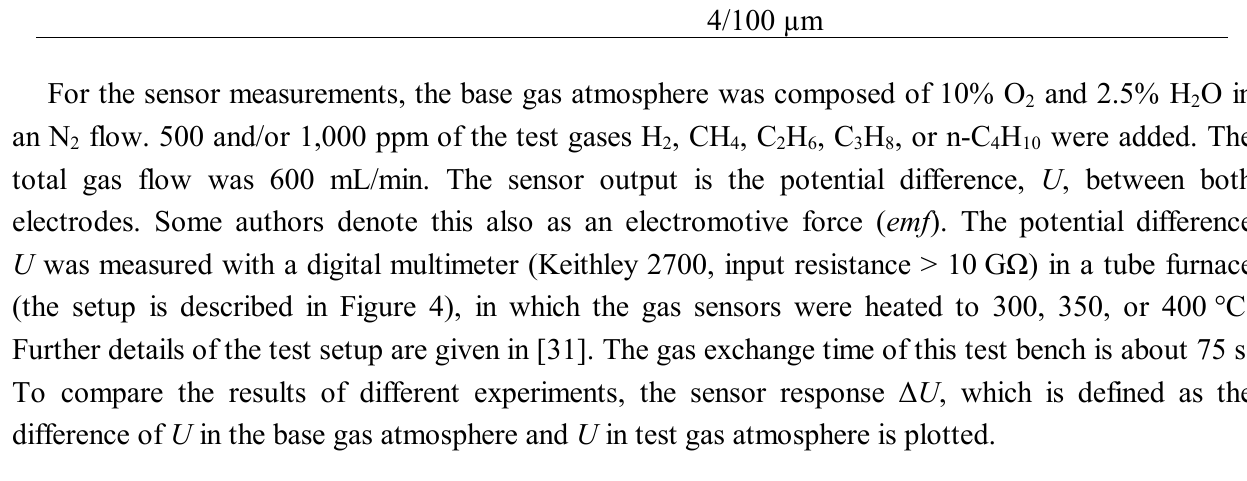
Figure 4. Setup of the gas sensor test